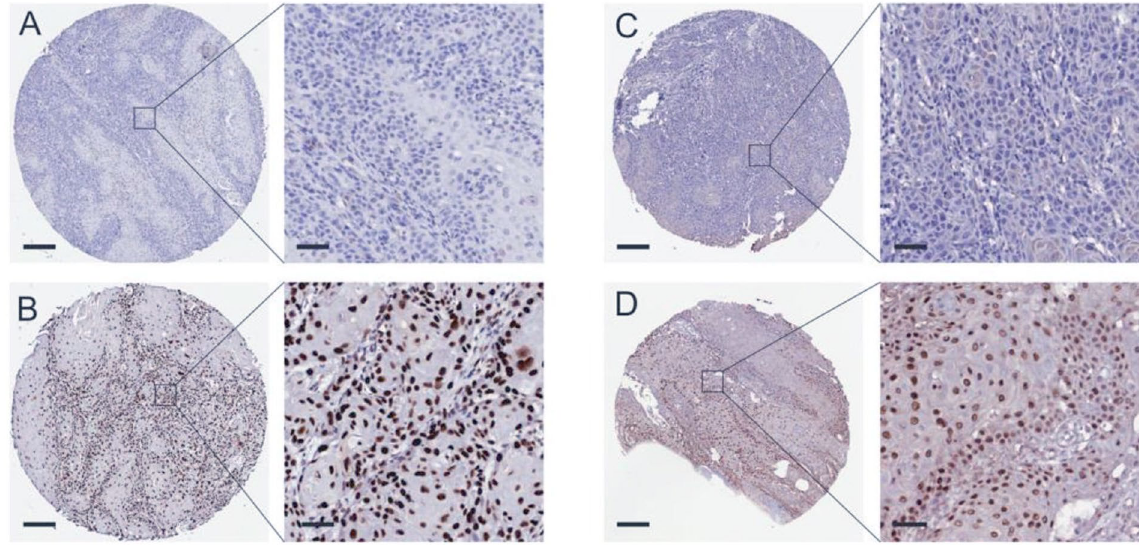
Figure 1. The immunohistochemical staining of c-Jun and Fra-1. Performed by EnVision system, protein immunoreactive substances were mainly displayed in the nucleus. ( A ) Low expression of c-Jun. Black scale bars at the bottom represent 200 µ m (left side) or 50 µ m (right side); ( B ) high expression of c-Jun; ( C ) low expression of Fra-1; ( D ) high expression of Fra-1.